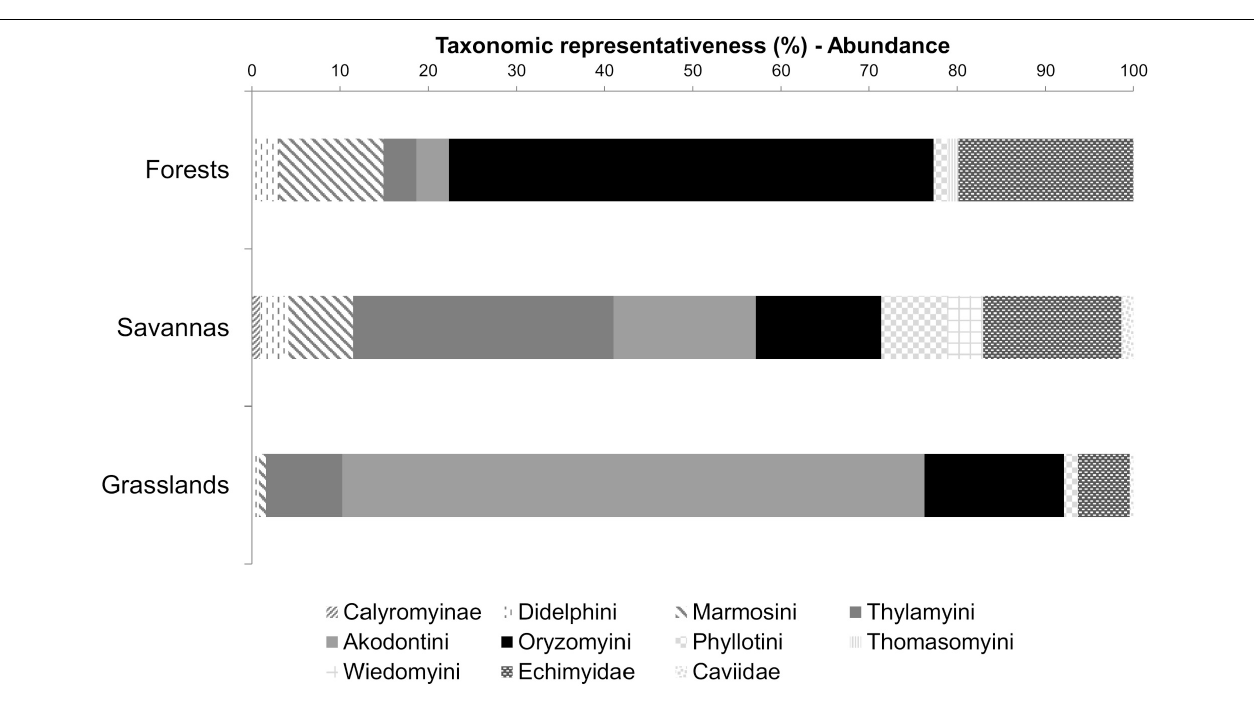
FIGURE 5 | Percentage of taxonomic groups based on the number of individuals surveyed at the three main habitat types across the 45 sites in the